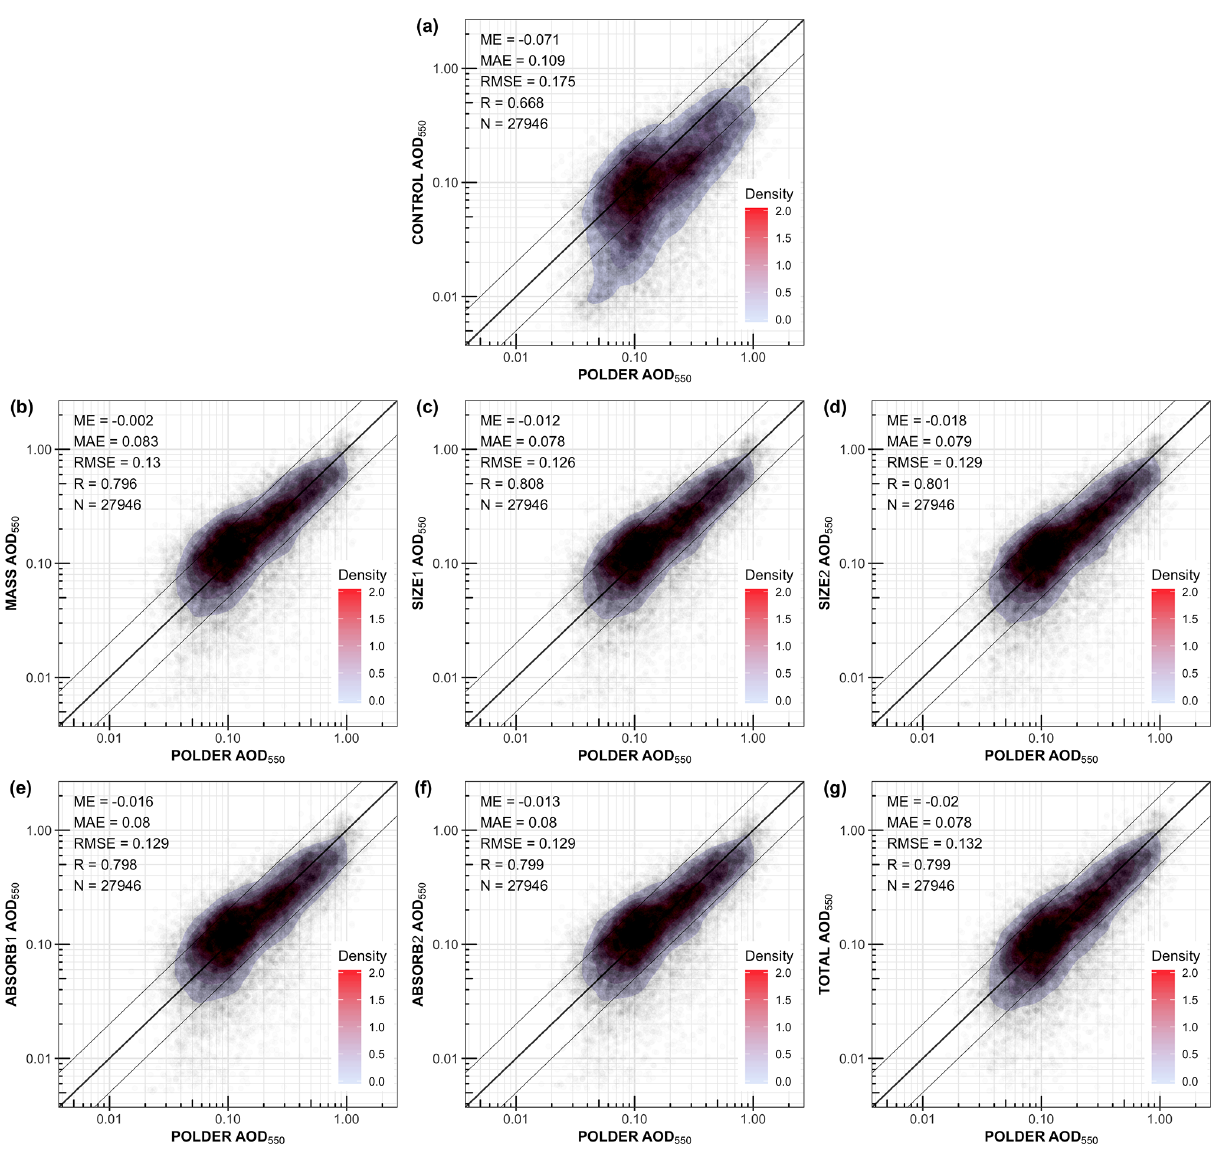
Figure 6. Aerosol optical depth at 550nm of POLDER against the core experiments, regarding all the available points of POLDER for the period 20 July to 28 August 2006. In each subplot, the bold line indicates the perfect model ( y = x ), while the two thinner lines confine the − 200% and 200% bias boundaries, respectively. The shade depicts the density of points. N represents the total number of